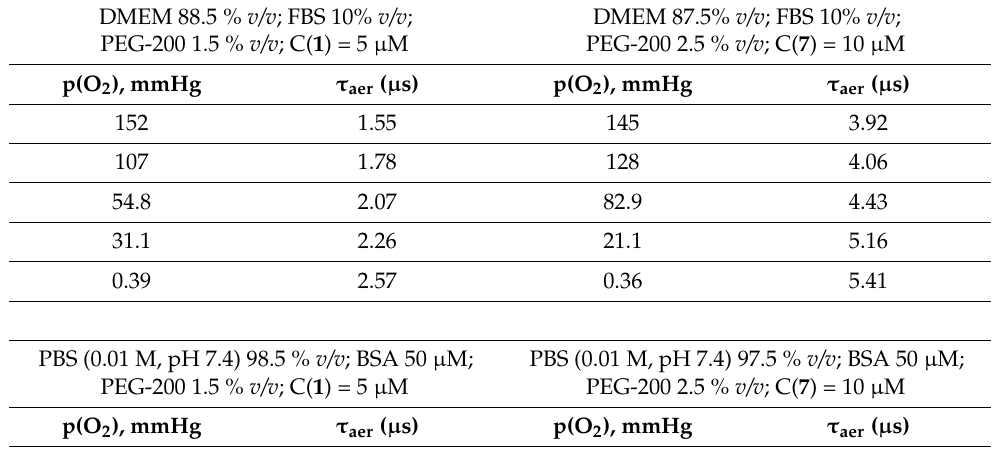
Table 2. Lifetime data for complexes 1 and 7 in aqueous solutions at different partial pressures of oxygen, 310 K, excitation at 355 nm, data acquisition at 720 nm.